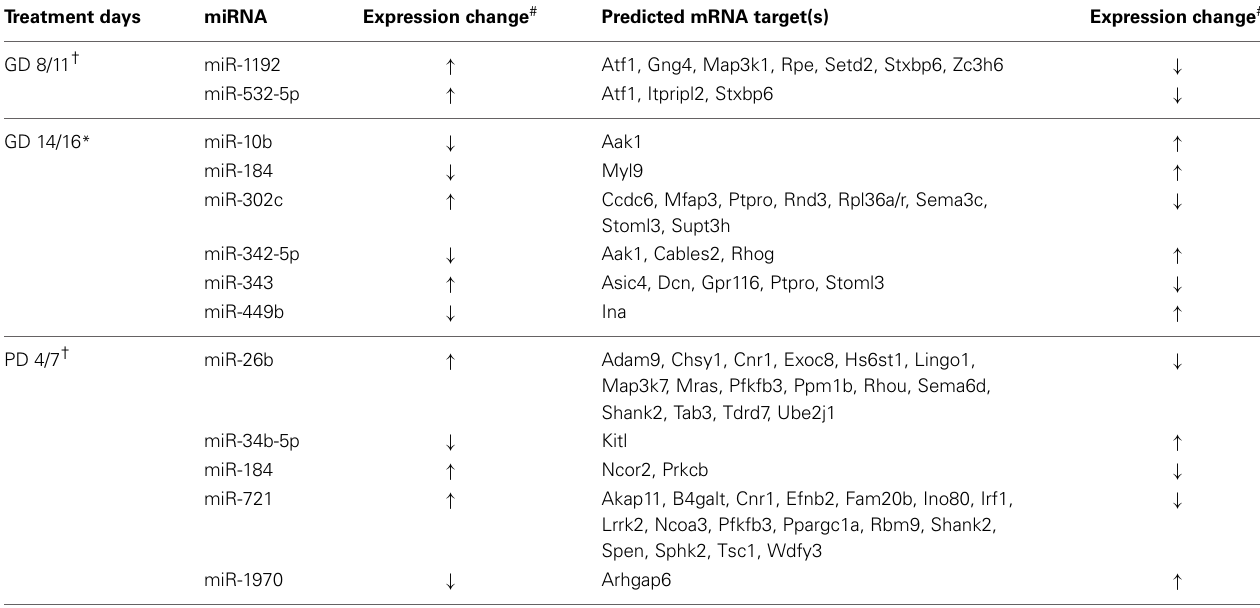
Table 1 | miRNAs and predicted mRNA targets with inversely correlated alterations following neurodevelopmental ethanol exposure. Treatment